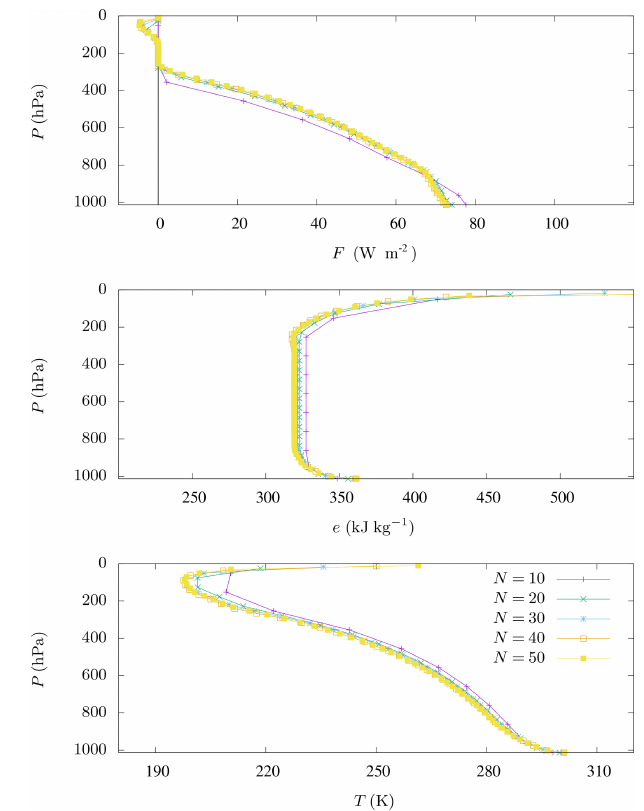
Figure B1. Energy flux F , specific energy e , and temperature T computed by our constrained model with e = C p T + gz + Lq s for imposed tropical atmospheric composition measured by Mc- Clatchey et al. (1972), with various resolutions N